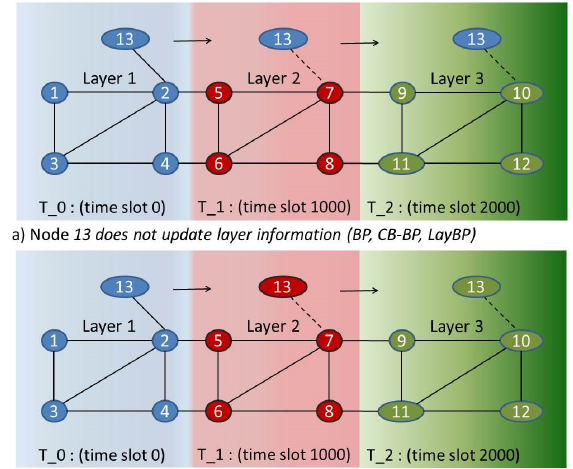
Figure 12. Dynamic network with 3